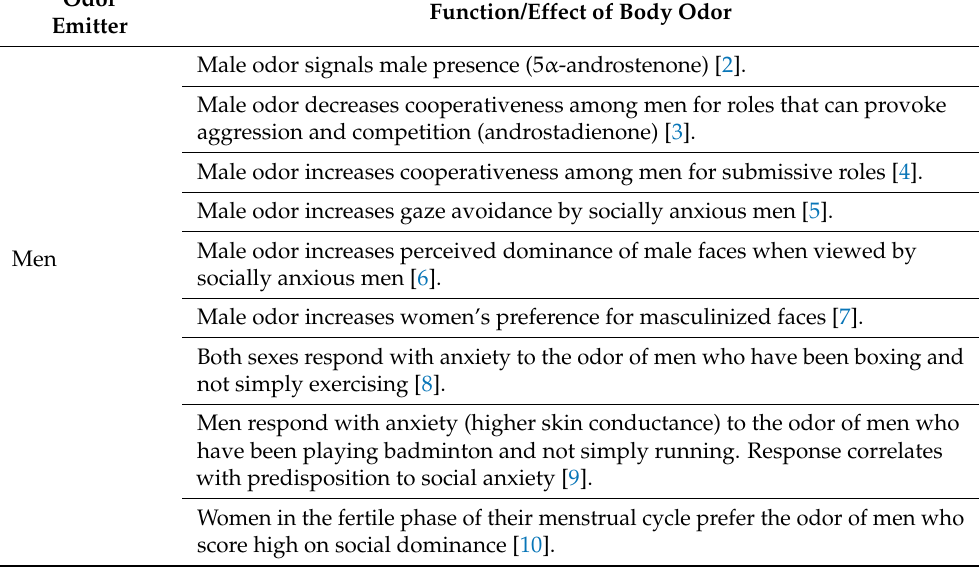
Table 2. Odor Emission/Detection by Gender, Age, and